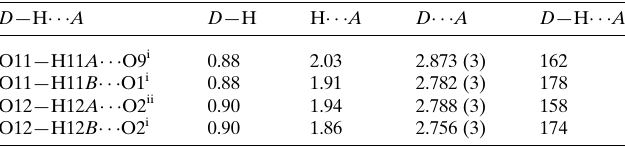
Table 1 Hydrogen-bond geometry (A˚ , (cid:4)